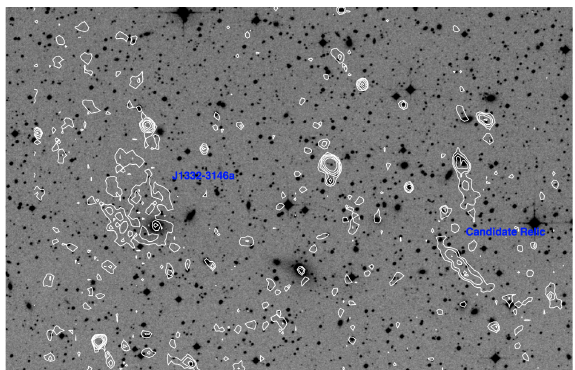
Figure 3. Radio contours at 325 MHz overlaid on the Digitized Sky Survey (DSS2) –red optical frame of the region between A3558 and A3562, where the two Shapley Concentration (SC) groups are located. The radio image is primary beam corrected. The contours start at 0.4 mJy/b and are drawn as powers of two. The resolution of the image is 16.3 (cid:48)(cid:48) × 11.9 (cid:48)(cid:48) . The two extended radio sources discussed here are labelled.